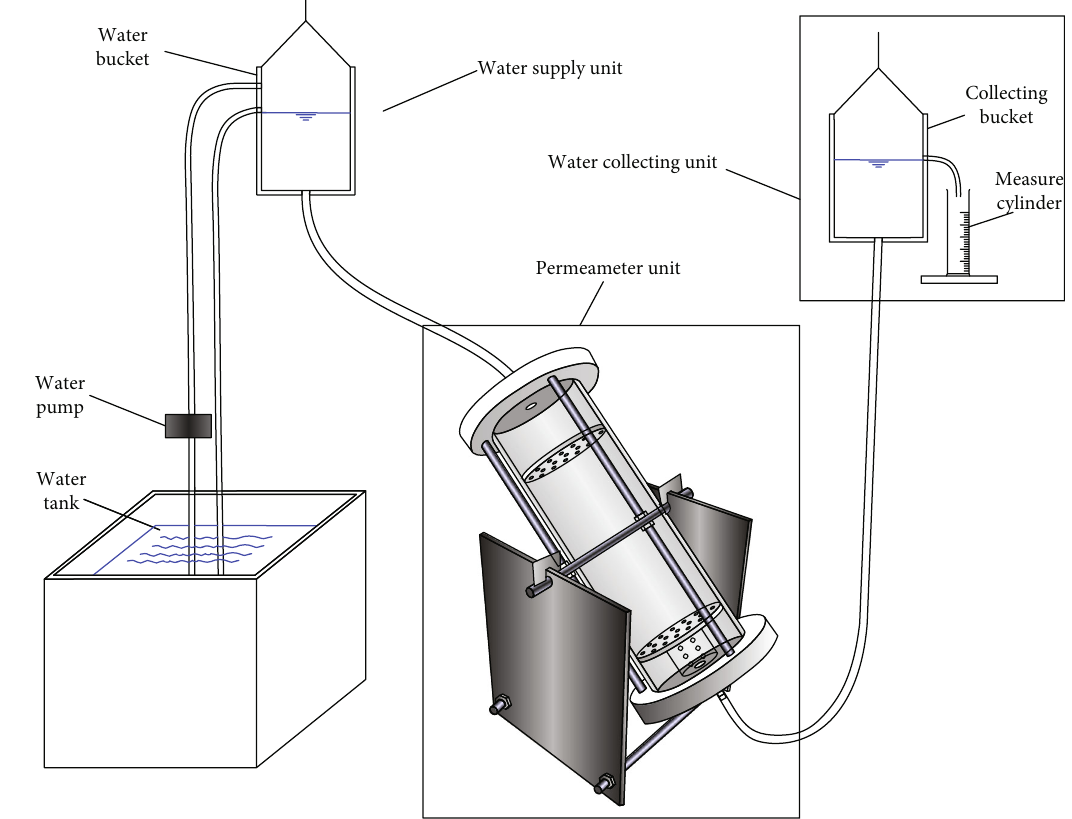
Figure 1: Overall schematic diagram of permeation apparatus.